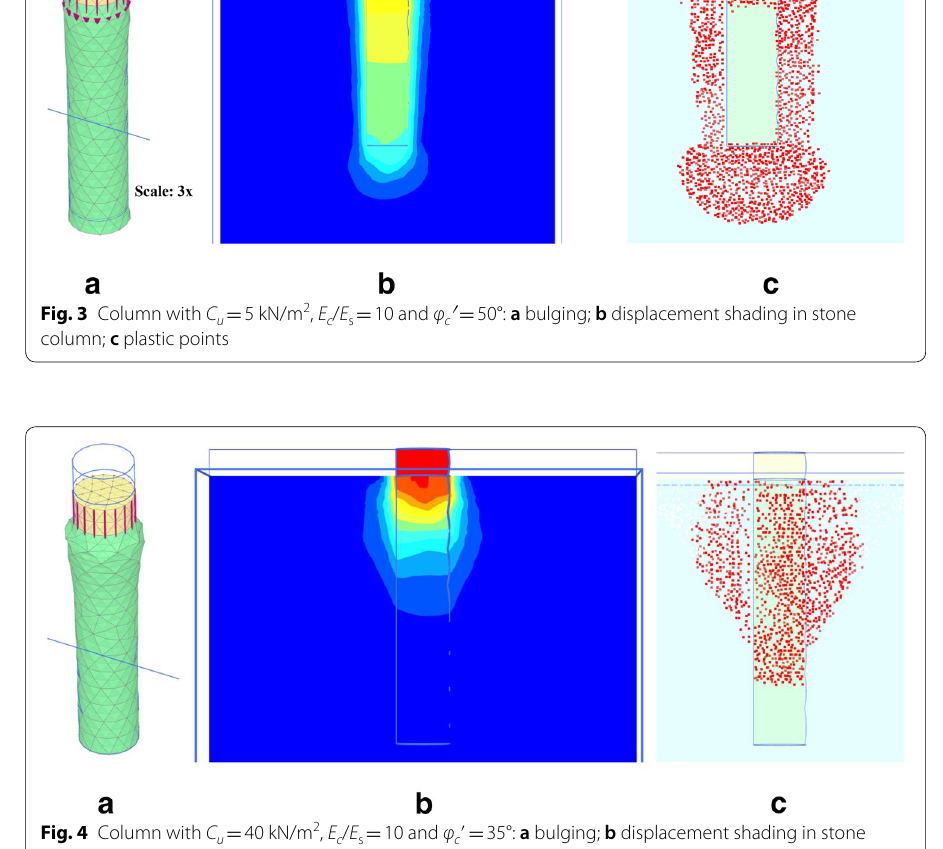
40 kN/m 2 , E c / E s 10 and φ c ′ 35°: a bulging; b displacement shading in stone = = =